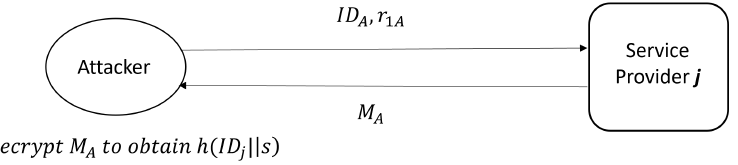
Figure 3. Attacker registration as a normal user.